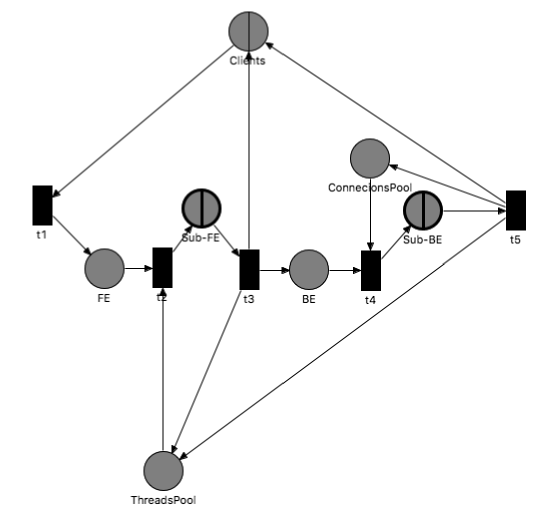
Figure 2. Main page of Web system model [4].